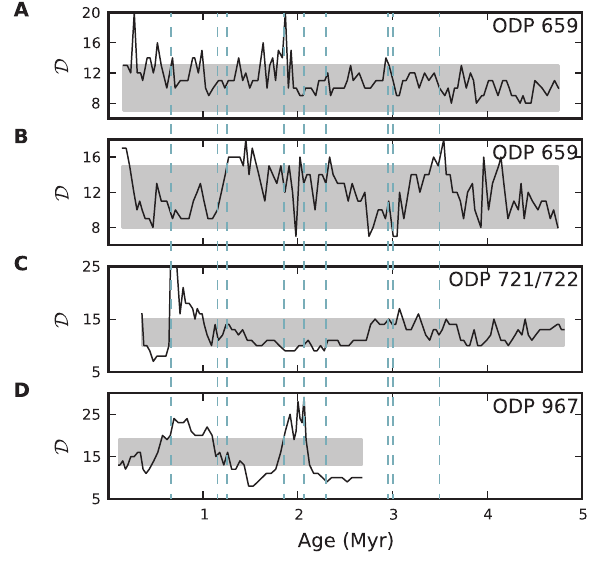
Table 2. Spearman’s ρ measuring rank-order correlations in the